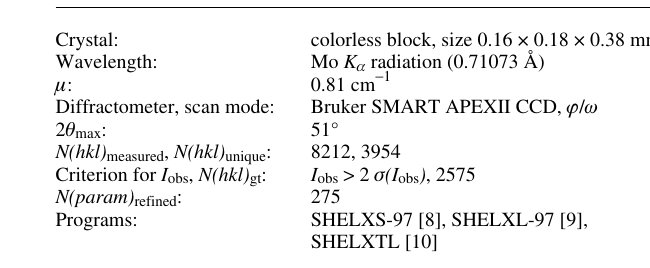
Table 1. Data collection and handling.